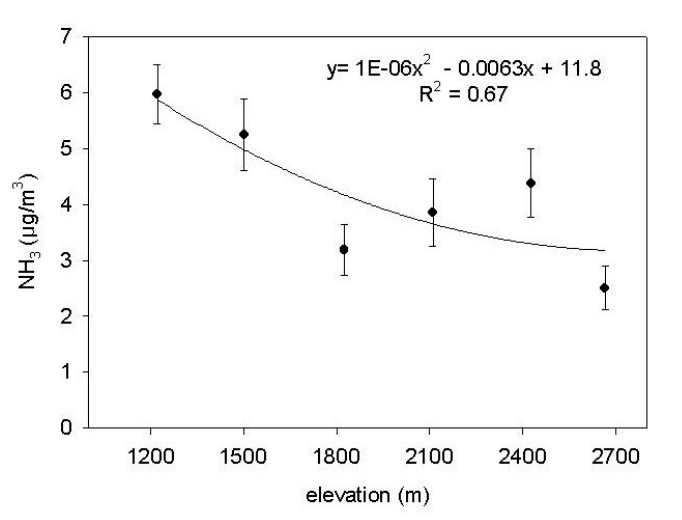
FIGURE 10. Changes of seasonal means of NH 3 (µg m -3 ) along the elevation gradient in the San Bernardino Mountains. Means ± SE.